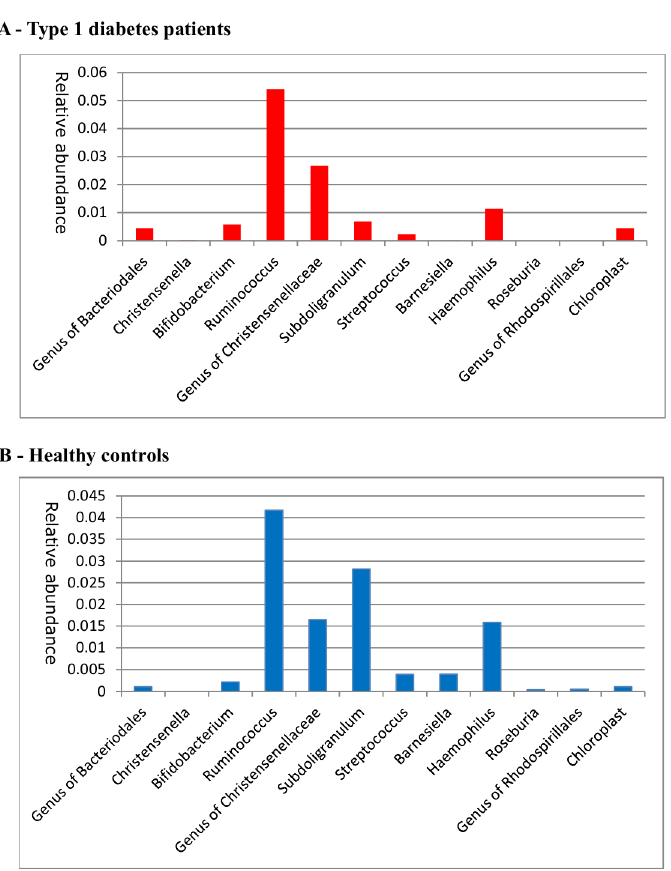
Fig 3. Most discriminating fecal species. Relativeabundancesof most discriminating fecal microbiota resulting from our elastic net analysisfor (A) T1D patients and (B) healthy controls (B).